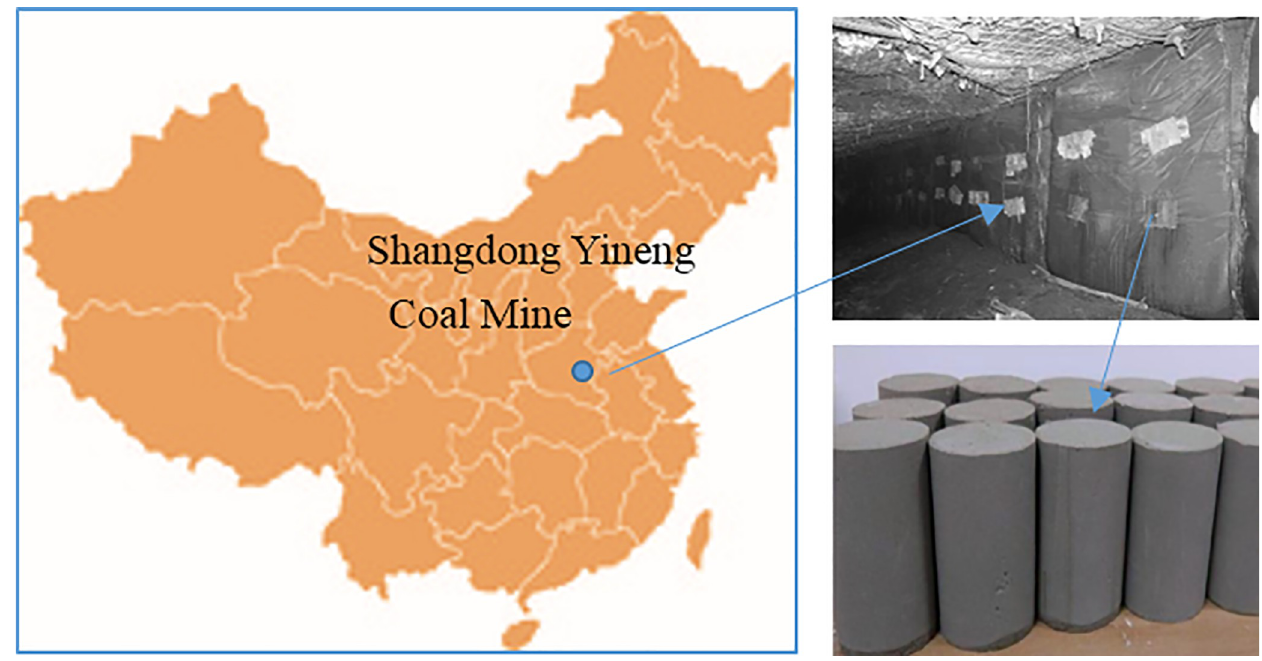
Fig 1. Source of high water materials.